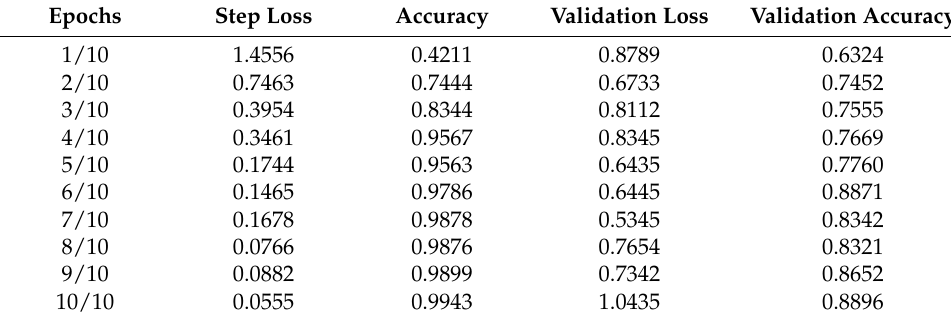
Table 3. Prescriptive data analysis for Conv2D VGG19 model